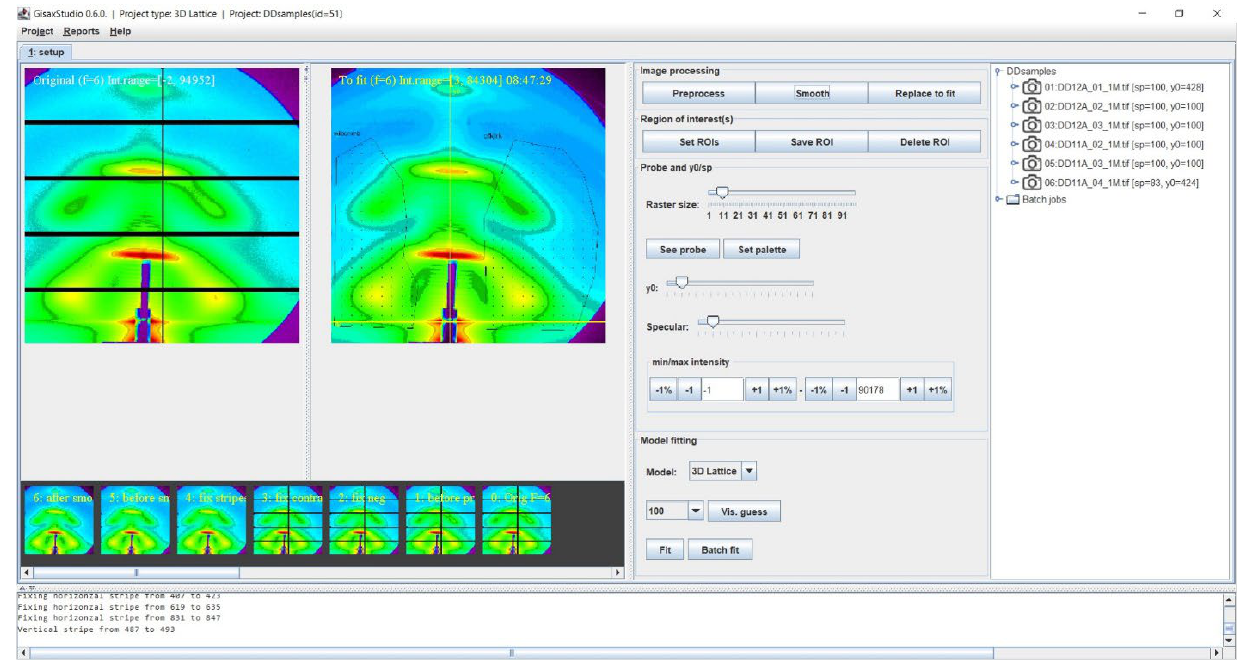
Figure 4. Window for setup the analysis options for 3dLattice experiment type. It contains the GISAXS map which should be analysed, as well as the options for image processing and simulation in the middle columns, followed by the list of loaded files in the current project on the right side.